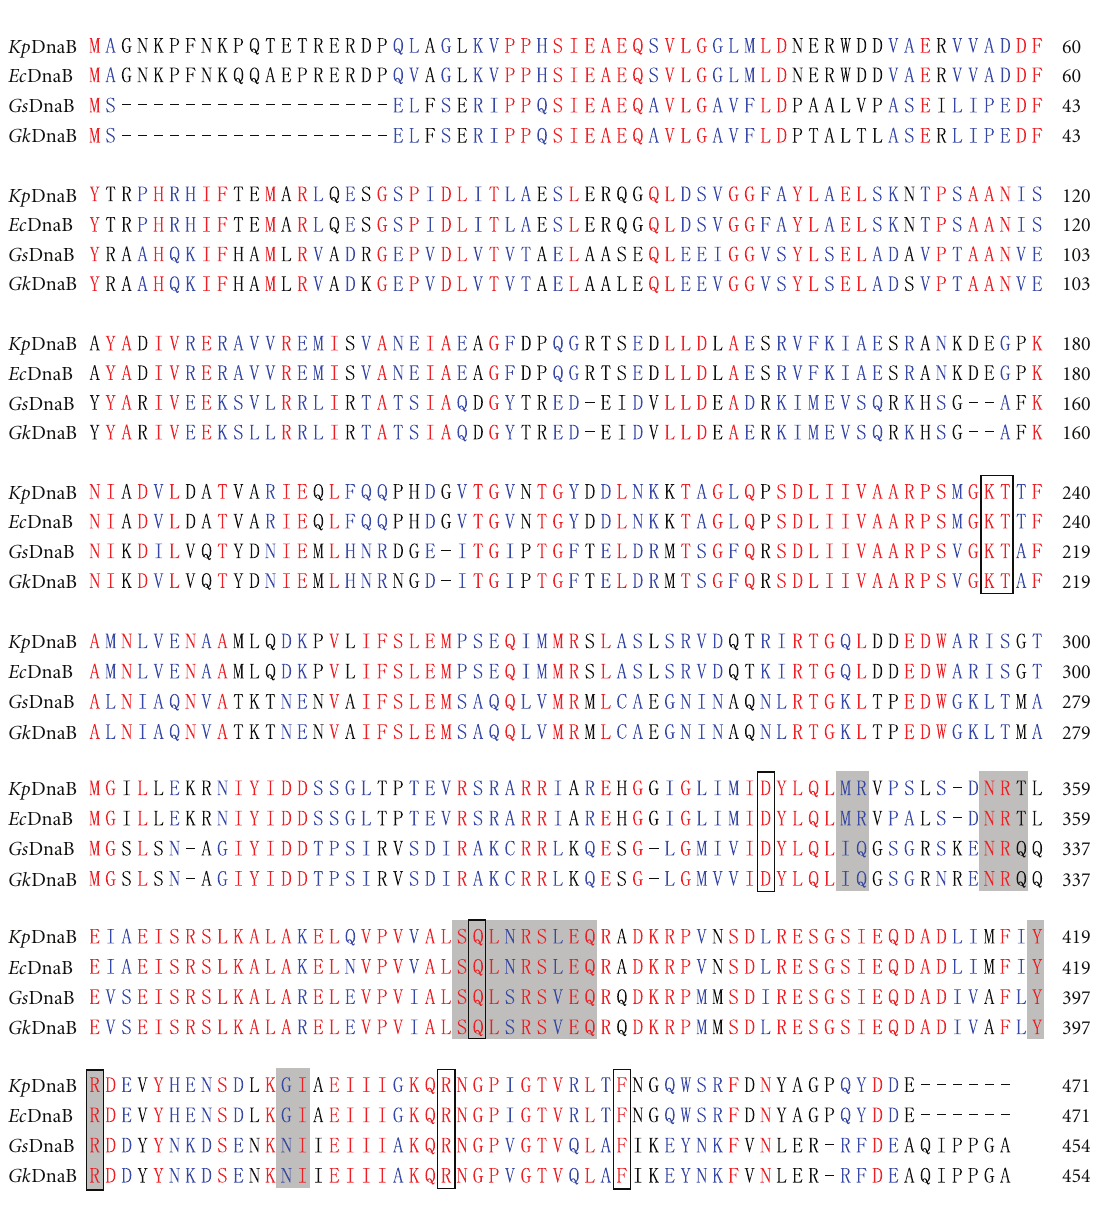
Figure 3: Multiple amino acids sequence alignment of DnaB helicases. Alignment was carried out using CLUSTALW2. Amino acid residues displaying 100% homology are highlighted in red, and those displaying similarity are highlighted in blue. The amino acids that are involved in ATP binding are boxed. The amino acids that are involved in ssDNA binding are shaded in gray. For clarity, only 4 bacterial stains are shown. Abbreviations: Kp , K. pneumoniae ; Ec , E. coli ; Gs , Geobacillus stearothermophilus [32]; Gk , Geobacillus kaustophilus